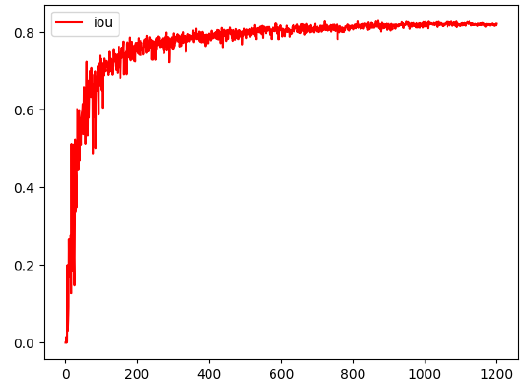
Figure 9. Trend graph of intersection over union (IoU) values in DBNet training.